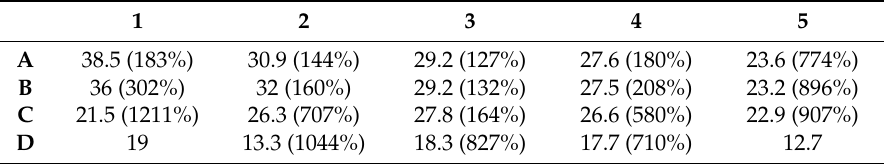
Table 10. SNR (dB) of phase image captured during 75 s heating.